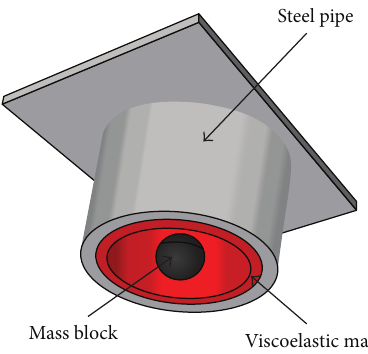
Figure 20: Three-dimensional diagram of a pounding